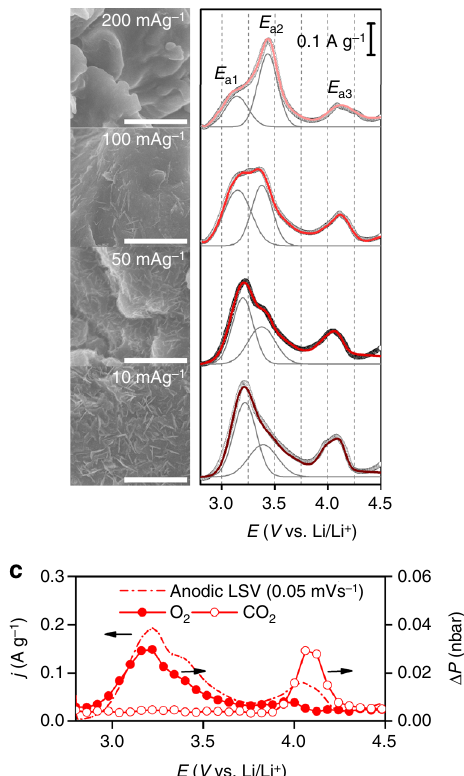
Fig. 5 Dependence of Li 2 O 2 morphology and corresponding RC pro fi les on DC current rate. a SEM images of CMK-3 electrodes with different current rates of 10, 50, 100, and 200 mA g – 1 carbon (from bottom to top) at a fi xed DC capacity of 500 mAh g – 1 carbon . The scale bars indicate 1 μ m. b Corresponding anodic LSV pro fi les at a sweeping rate of 0.05 mV s − 1 . The black open circles represent experimental LSV curve whereas the red lines indicate the sum of the deconvoluted curves. The deconvoluted peaks above 4.0 V have been omitted for simplicity. c Representative in situ gas analysis linked with anodic LSV for Li 2 O 2 formed at a DC current rate of